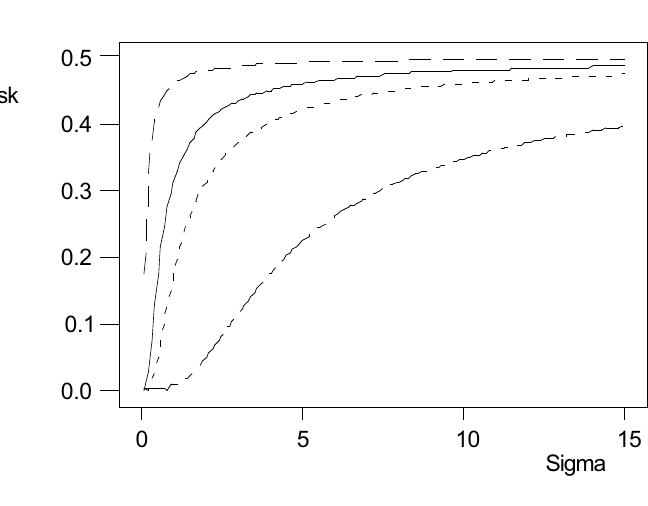
Figure 1 – Plot of the global risk measure of equation (1) as a function of the standard deviation of the returns for various values of the cut-off return expressed in standardized scores. Lower line refers to -4. Upper line corresponds to -0.5 The solid line considers a probability of 0.99 corresponding to the Basle